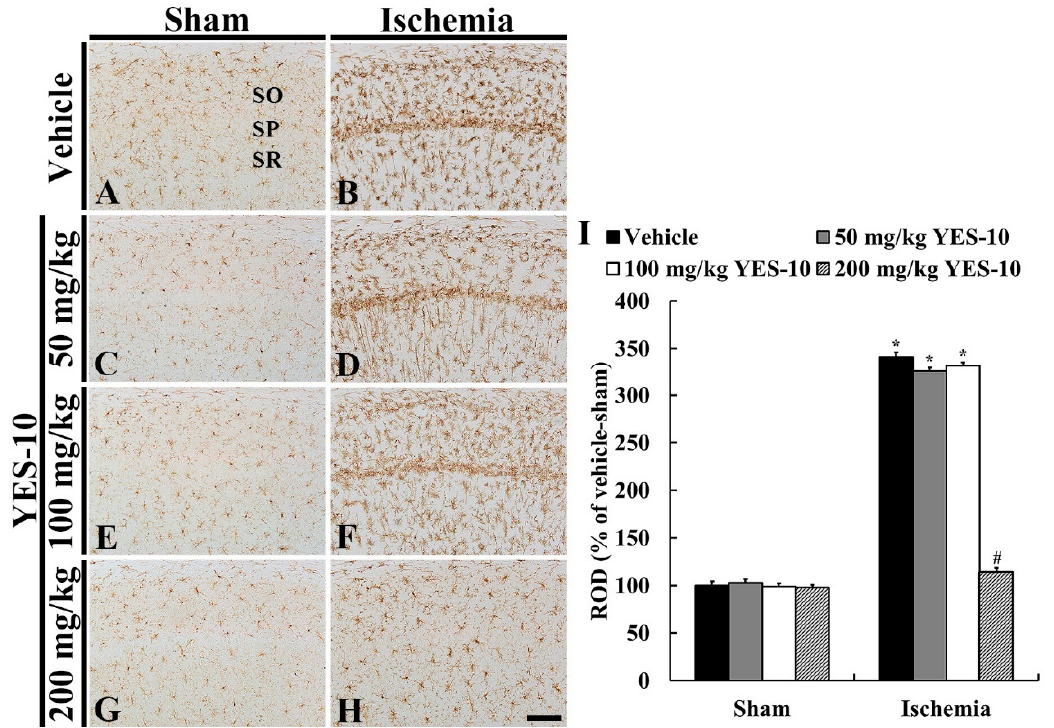
Figure 5. Immunohistochemistry for Iba-1 in the hippocampal CA1 field of the vehicle/sham ( A ), 50 mg/kg YES-10/sham ( C ), 100 mg/kg YES-10/sham ( E ), 200 mg/kg YES-10/sham ( G ), vehicle/ischemia ( B ), 50 mg/kg YES-10/ischemia ( D ), 100 mg/kg YES-10/ischemia ( F ) and 200 mg/kg YES-10/ischemia ( H ) groups at 5 days post-ischemia. Iba-1 immunoreactive microglia in all sham groups are similar. In the vehicle/ischemia group, the cytoplasm and processes of Iba-1 immunoreactive microglia is hypertrophied and are thickened, respectively. In the 50 and 100 mg/kg YES-10/ischemia groups, Iba-1 immunoreactive microglia are similar to those of the vehicle/ischemia group. In contrast, in the 200 mg/kg YES-10/ischemia group, Iba-1 immunoreactive microglia are less hypertrophied than those in the vehicle/ischemia group. Scale bar = 100 μ m. ( I ) ROD as % of Iba-1 immunoreactive structures in the CA1 field at 5 days post-ischemia (n = 7 in each group, * P < 0.05 versus vehicle/sham group, # P < 0.05 versus vehicle/ischemia group). The bars indicate the means ± SEM.